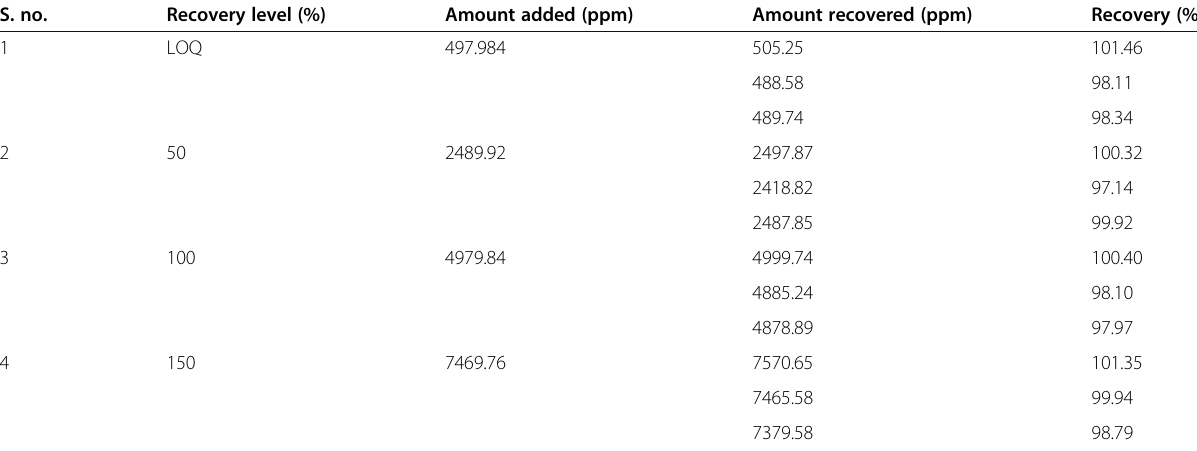
Table 9 Results of recovery study for ethanol